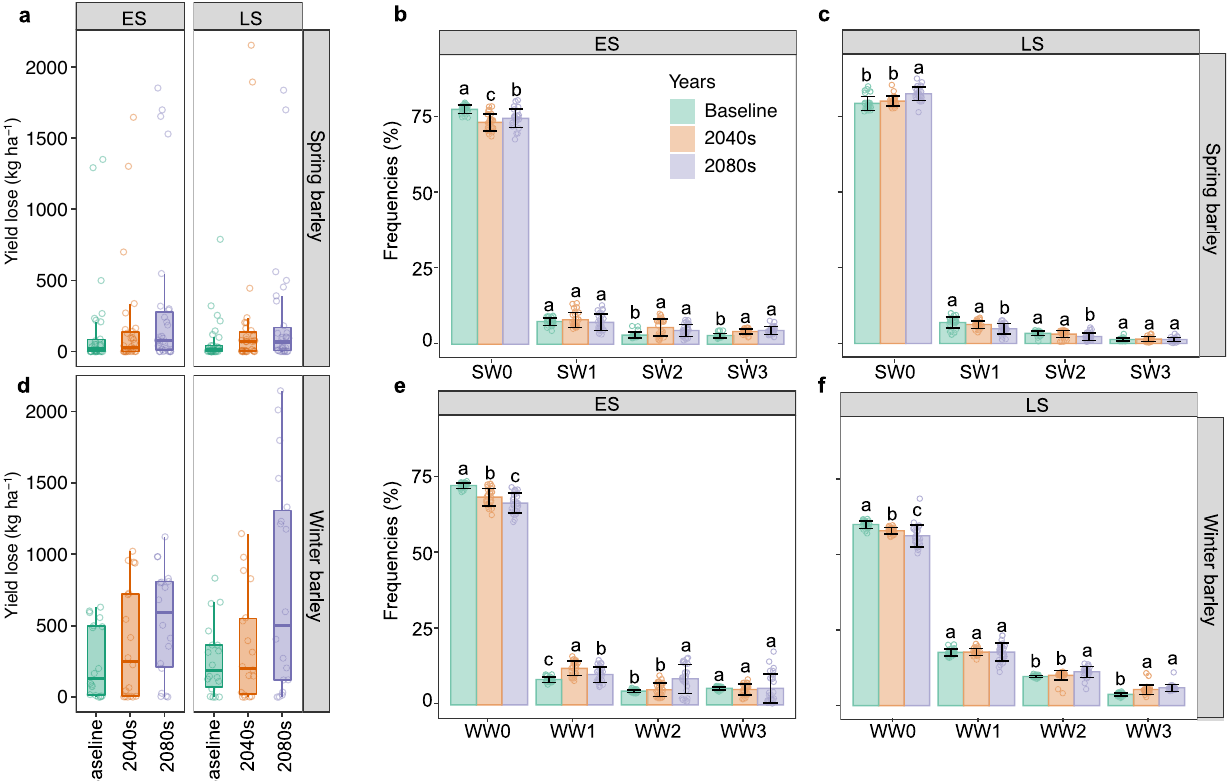
Fig. 4 | Grain yield penalty and waterlogging stress patterns for the baseline (1985 – 2016),2040(2030 – 2059)and2080(2070 – 2099). Grainyieldpenaltiesare shown for spring ( a ) and winter ( d ) barley across sites and genotypes forrelatively early or late sowing (ES, LS) at each site. Boxplots indicate yield penalty for spring andwinterbarleyacrosssitesandGCMs( n =27);boxboundariesindicate25thand 75th percentiles, whiskers below and above the box indicate the 10th and 90th percentiles, respectively. Waterlogging stress patterns for spring barley include SW0 (minimal waterlogging); SW1 (low moderate-late waterlogging); SW2 (late- onset moderate waterlogging); SW3 (late-onset severe waterlogging) and winter barley, WW0 (minimal waterlogging); WW1 (low early-onset waterlogging relieved later); WW2 (moderate early-onset waterlogging); WW3 (severe early-onset water- logging). Data in ( b ), ( c ), ( e ) and ( f ) are presented as mean±standard errors of the